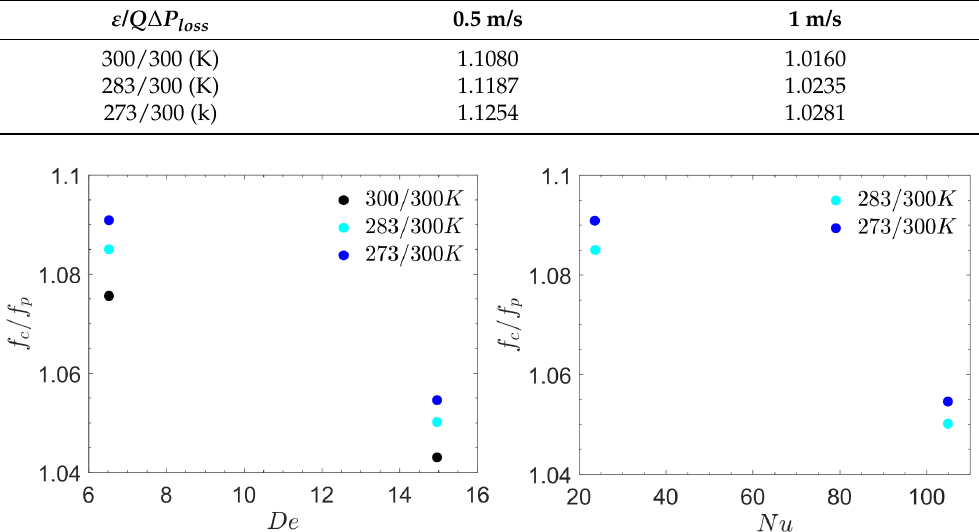
Figure 14. Correlated friction factor f c / f p as a function of Dean number De at different temperature conditions ( left ). Correlated friction factor f c / f p as a function of Nusselt number Nu at different temperature conditions ( right ). Table 1. Pressure loss coefficient in different cases.